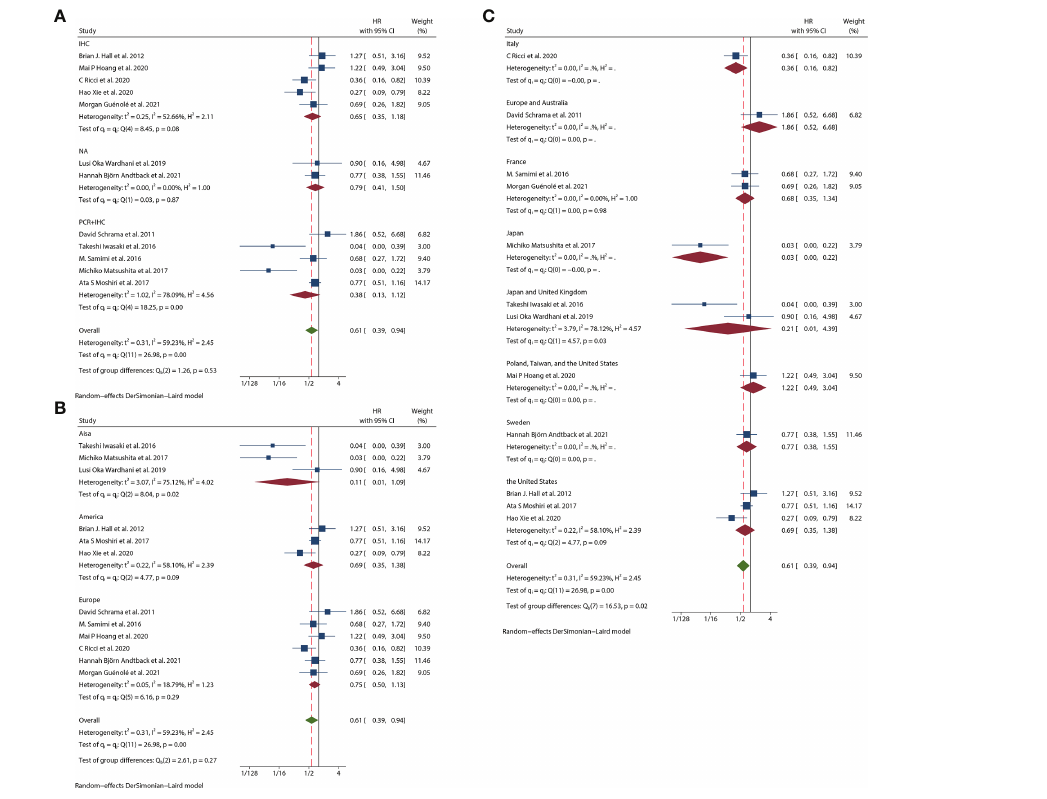
FIGURE 3 Overall survival (OS) subgroup analyses. (A) OS subgroup analysis in term of different detection methods; (B) OS subgroup analysis of different continents; (C) OS subgroup analysis of different study